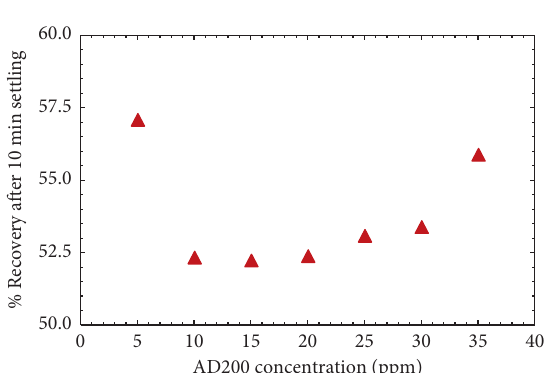
Stability of suspension in 10 wt. % slurry of slime (Figure 6)